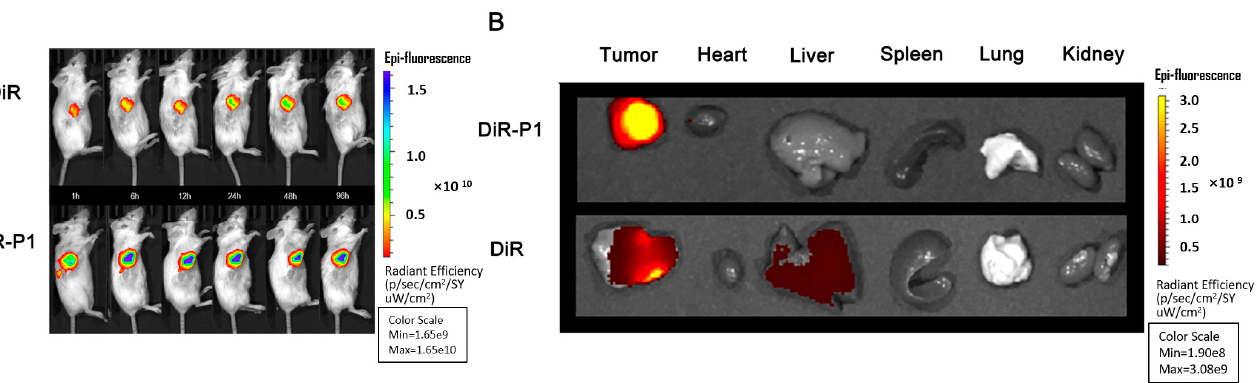
Figure 4. ( A ) The body weight change curve of mice after administration. ( B ) The tumor volume change curve of mice after administration. ( C ) Photographs of the tumors harvested from the mice in the blank group (NS), the DOX group (DOX), and the DOX-P1 group (DOX-P1) 7 d after administration (n = 5). ( D ) H&E staining (top) and TUNEL assays (bottom) of tumor sections after different treatments within 7 d. NS—normal saline; DOX—doxorubicin; DOX-P1—doxorubicin- loaded P1 nonapeptide hydrogel (one-way ANOVA, mean ± SD, * p < 0.05).